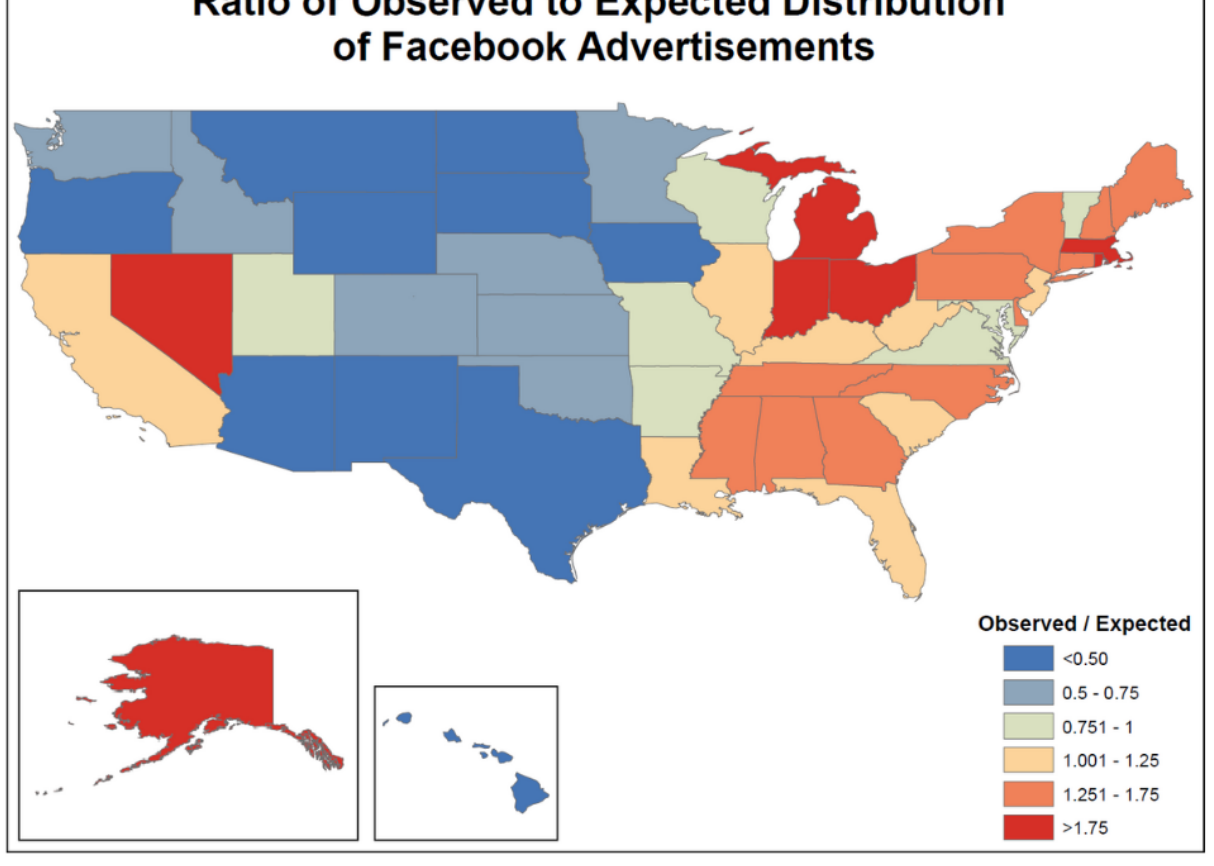
Figure 1. Ratio of observed to expected geographical distribution of Facebook ads. Data obtained from the United States National Agricultural Statistics Service 2017 Census of